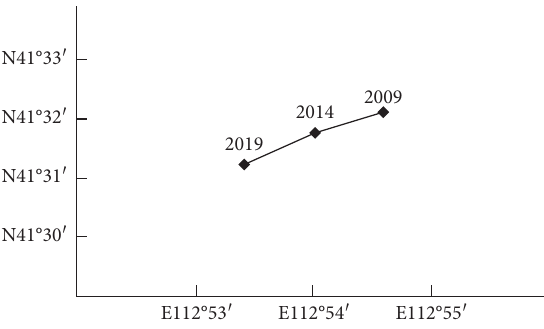
Figure 3: Moving map of the center-of-gravity of town construction land from 2009 ‒ 2019.